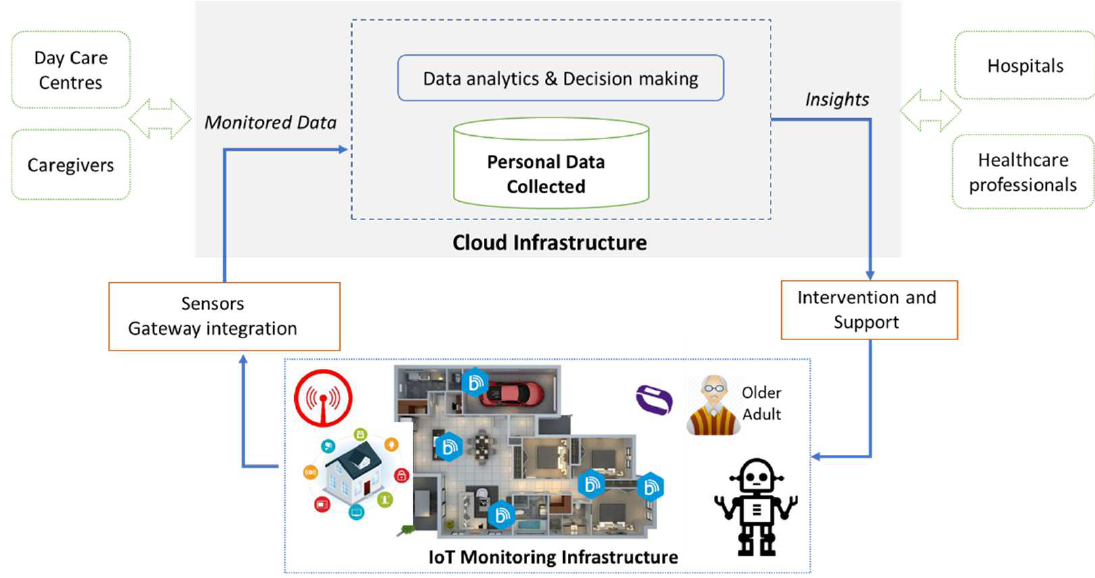
Figure 1. Conceptual architecture of a cloud-based AAL system.